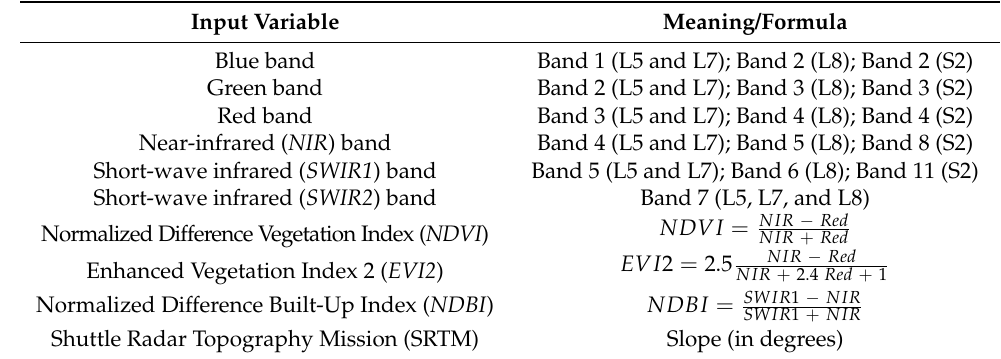
Table 4. List of predictive input variables considered to be included in the classification procedures. TM Landsat-5 (L5), ETM+ Landsat-7 (L7), OLI Landsat-8 (L8), MSI Sentinel-2 (S2), and Shuttle Radar Topography Mission